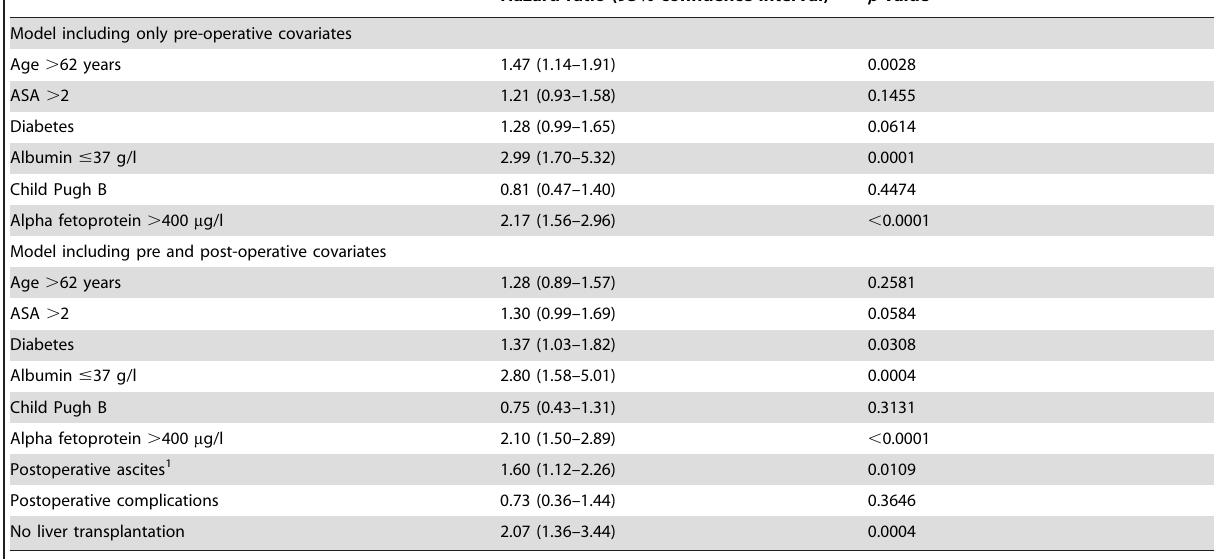
Table 4. Multivariate survival